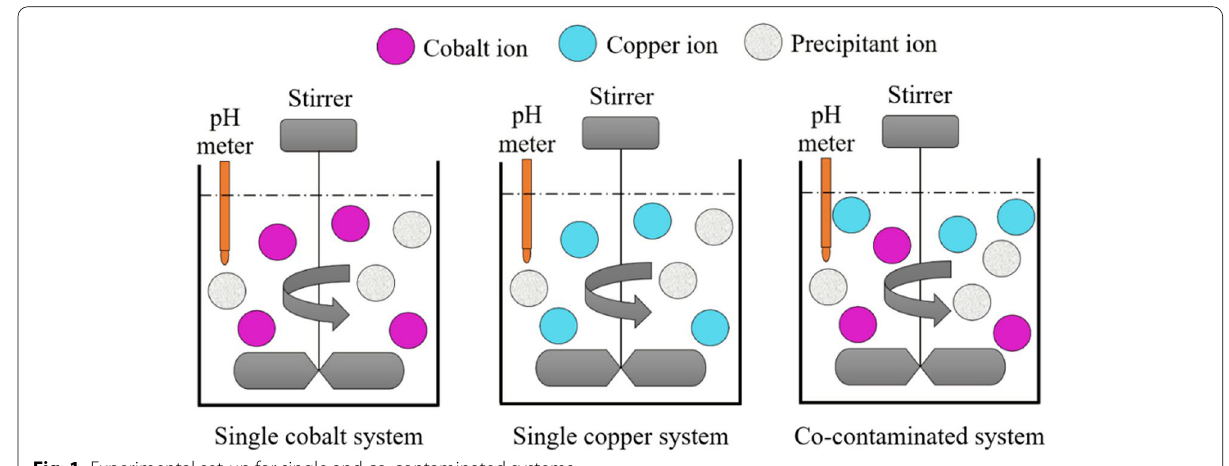
Fig. 1 Experimental set‑up for single and co‑contaminated